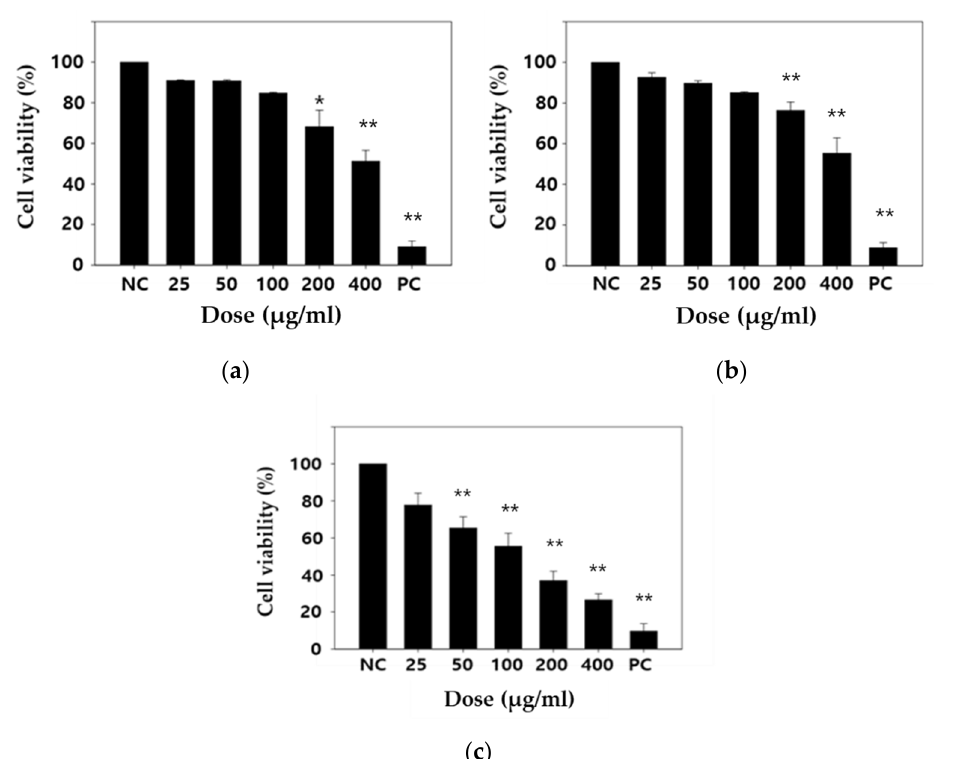
Figure 2. Cytotoxicity measurement data for the human lung embryo fibroblast (WI-38) treated with increasing doses of diesel exhaust particles (DEP). ( a ) The 24 h treatment group; ( b ) the 48 h treatment group; ( c ) the 72 h treatment group. The statistically significant difference is indicated by * p < 0.05 and ** p < 0.01 when compared with the negative control. Values are means of triplicate measurements. NC: negative control (0.2% DMSO); PC: positive control (1% Triton X- 100).